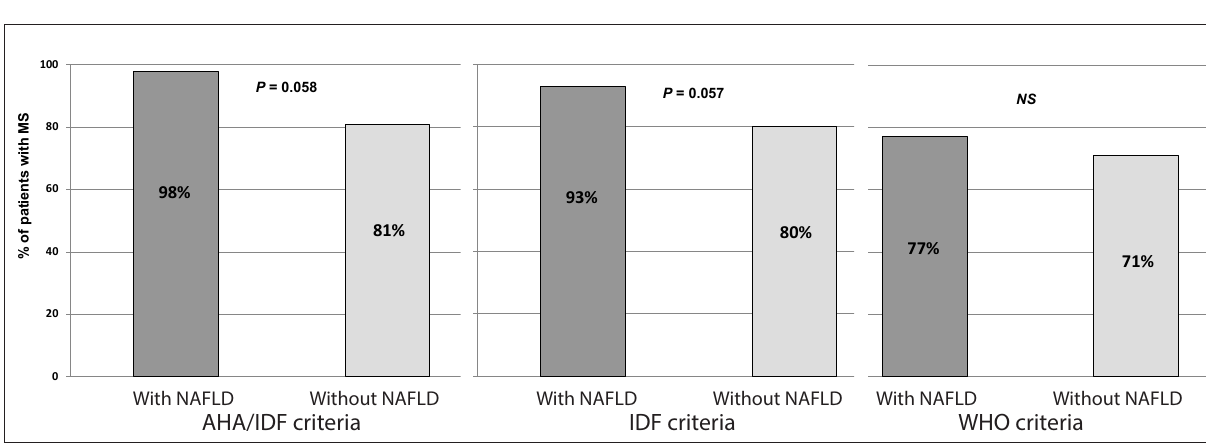
Fig. 1. Frequency of metabolic syndrome in patients with DM2 with and without NAFLD. Metabolic syndrome diagnosed on the basis of AHA/IDF criteria (ref. 15 ), IDF criteria (ref. 18 ) and WHO criteria (ref. 19